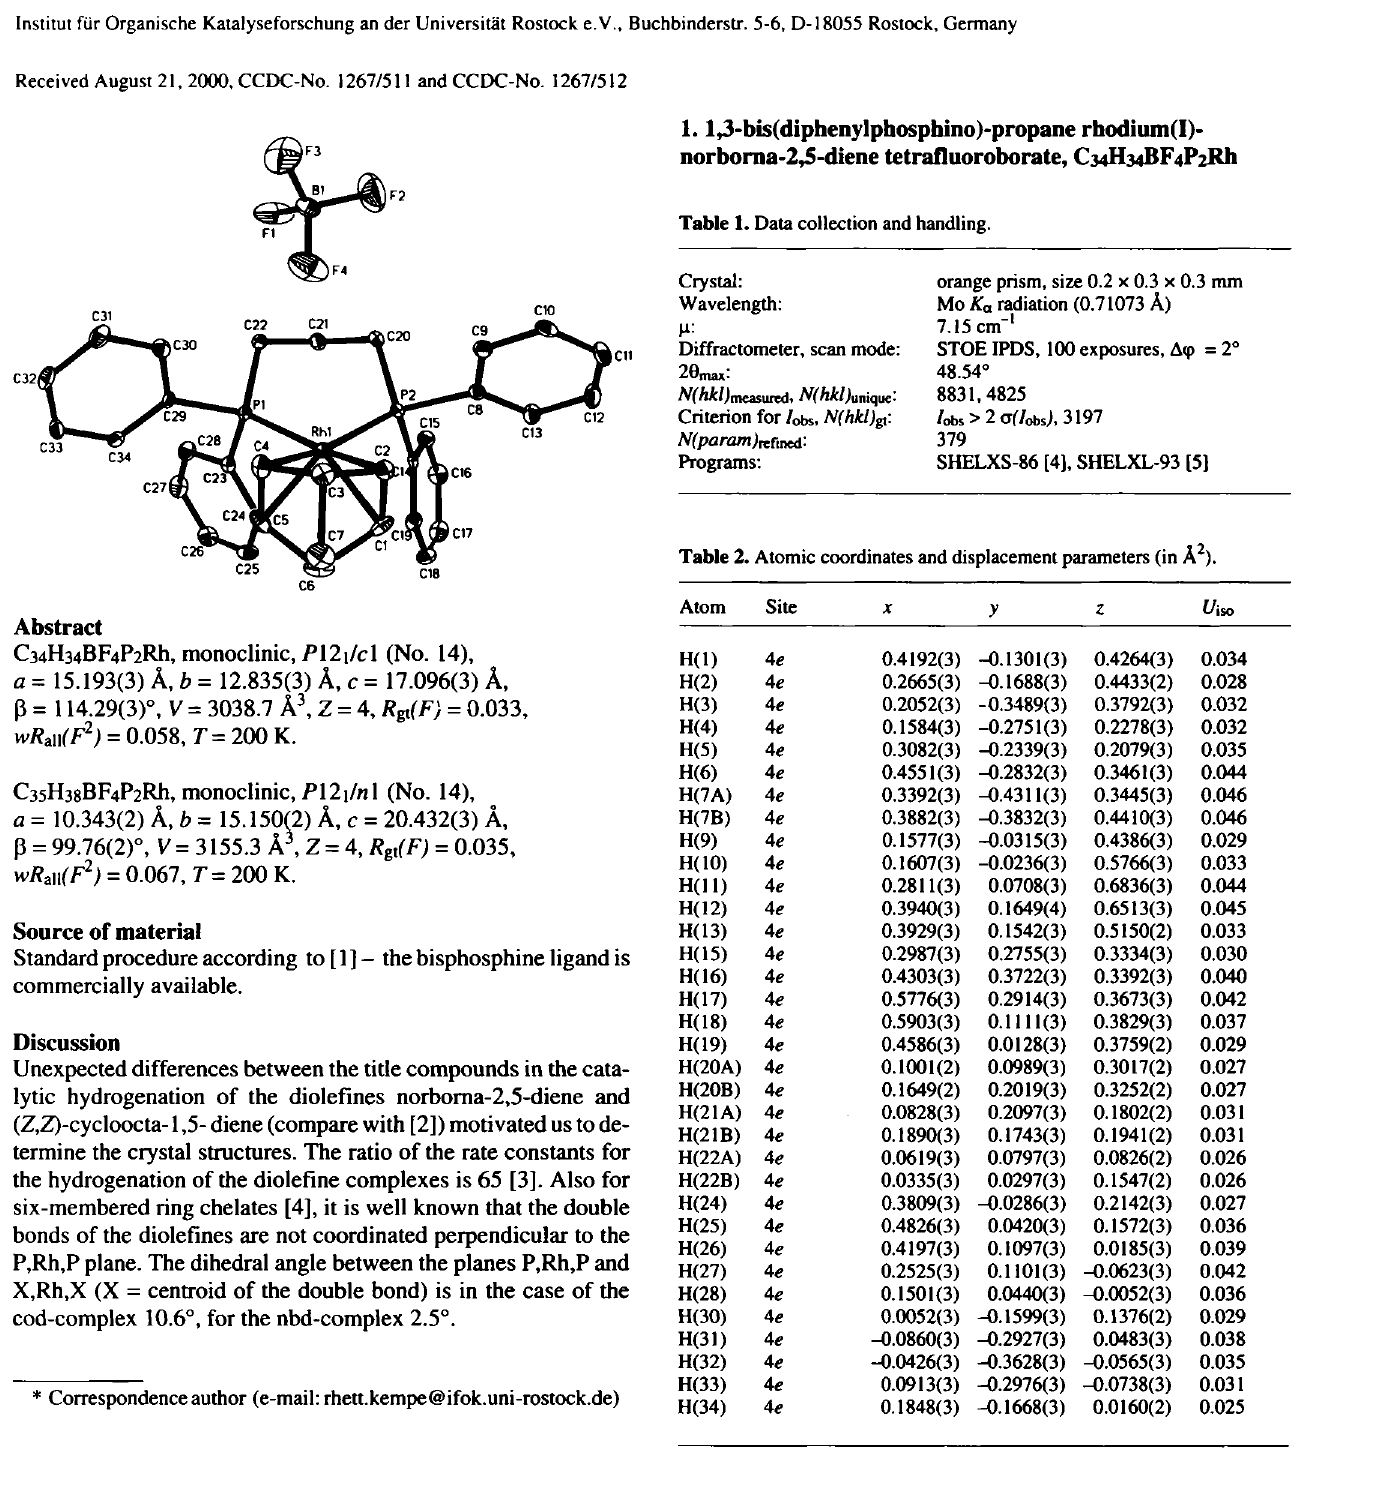
Table 2. Atomic coordinates and displacement parameters (in A 2